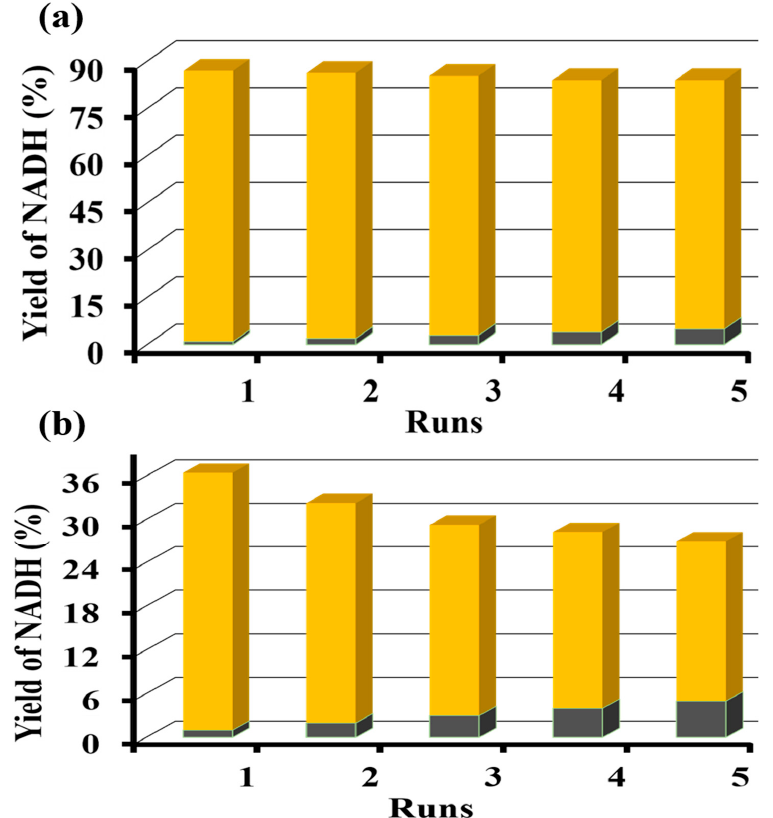
Figure 7. The recycle stability for NADH regeneration by the ( a ) EC-R@ACC photocatalyst and ( b ) EC-R photocatalyst.